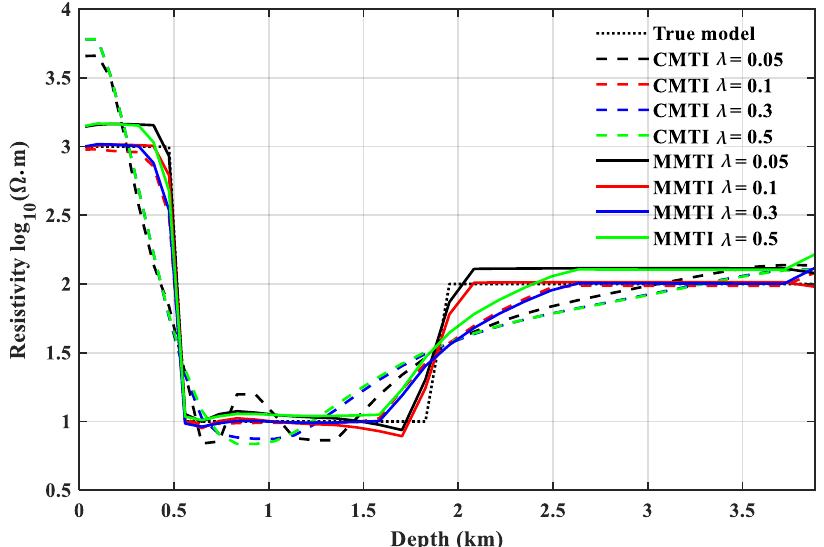
Figure 8. Comparison of single-point recovery curves.